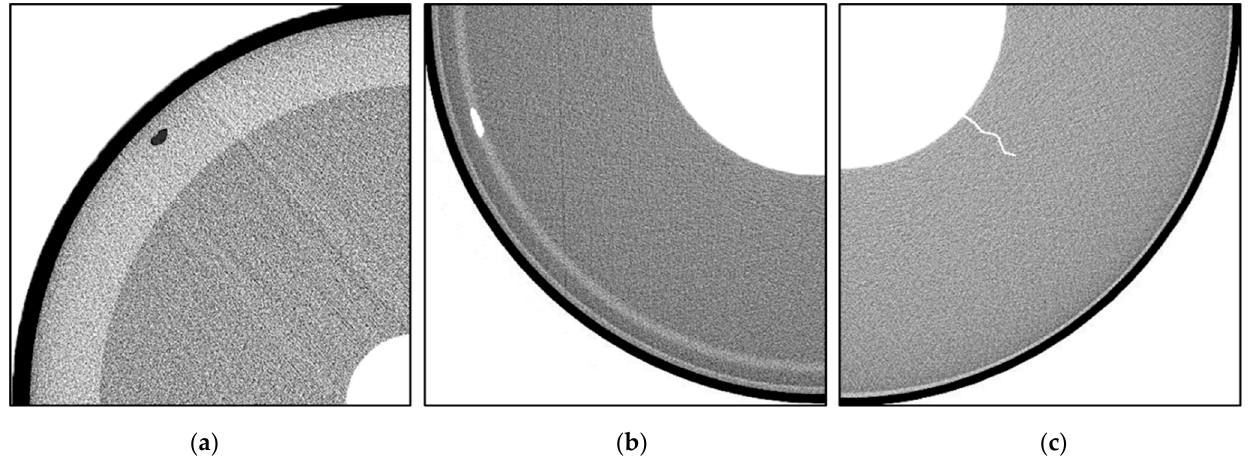
Figure 7. The three images with a single defect: ( a ) the image with slag; ( b ) the image with bubble; ( c ) the image with crack. Table 1. The PSNR values of three different images with a single defect.